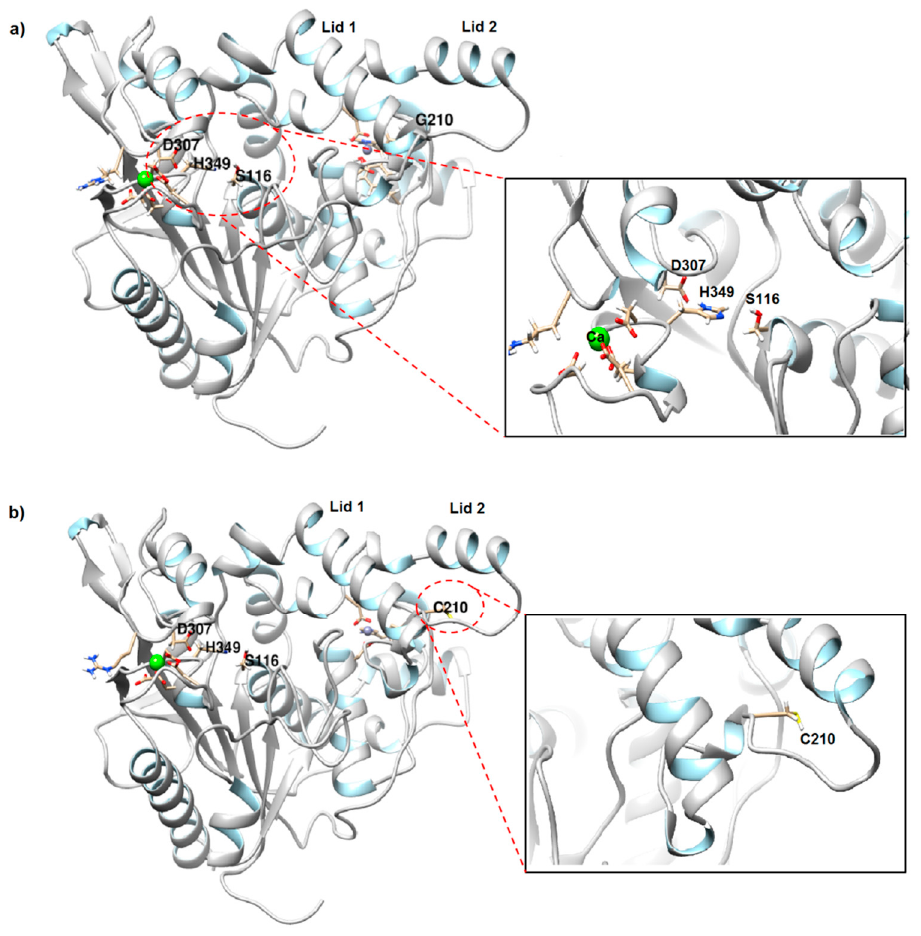
Figure 1. Predicted 3D structure of lipases. ( a ) rT-M386 and ( b ) mutant G210C. Ca 2+ and Zn 2+ are colored in green and gray solid circle, respectively. Catalytic triad of rT-M386 and G210C comprised of S116, D307 and H349 situated on β -sheet, loop and turn, respectively. Mutation point is labeled as C210. Models are generated by Chimera in linear ribbon.